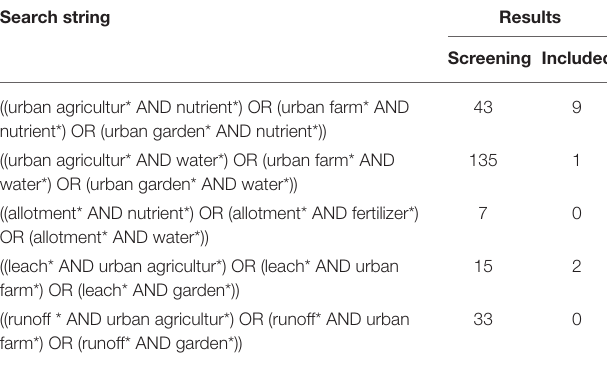
TABLE 1 | Search strings for the identification of relevant studies through Web of Science. Search string Results